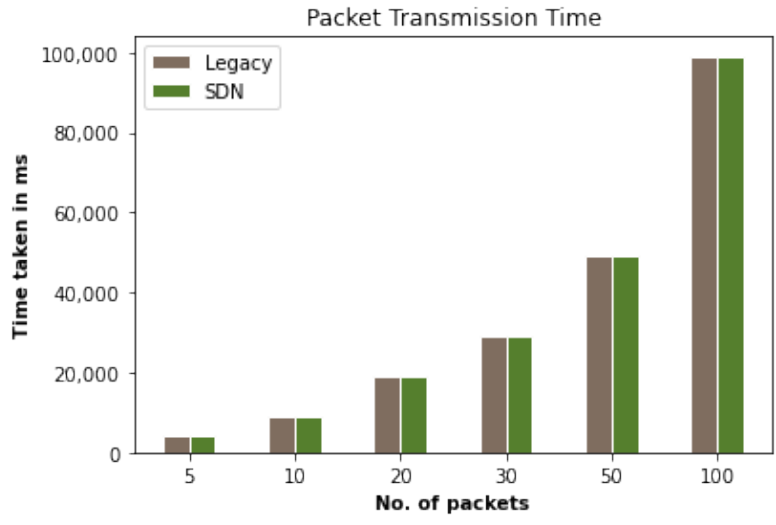
Figure 10. PTR for AS65000/SDN as a transit network.